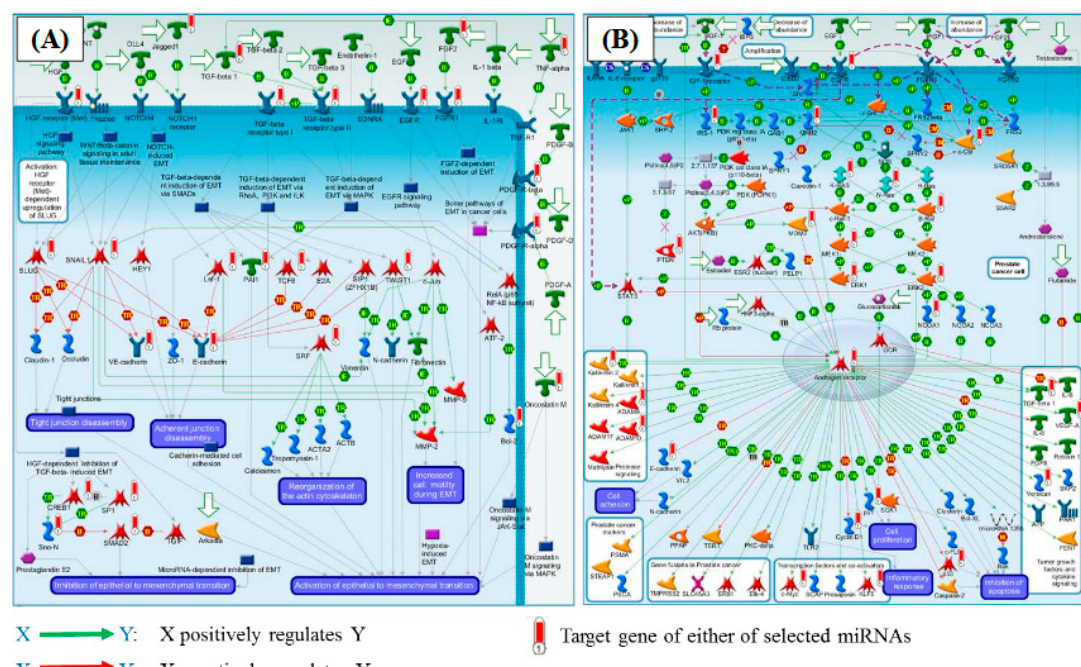
Figure 4. Representative pathways enriched with possible target genes of eight miRNAs whose plasma levels showed positive and negative correlations with CHA 2 DS 2 -VASc score and CA, respectively. ( A ) Pathway maps for “Development_Regulation of epithelial-to-mesenchymal transition (EMT)” and ( B ) “Pathway maps for “Androgen receptor activation and downstream signaling in Prostate cancer”, the 1st and 2nd most enriched pathways, respectively, querying possible target genes of the miRNA whose plasma levels showed positive correlations with CHA 2 DS 2 -VASc score (Table 3). Red bar represents possible target genes of miRNAs whose plasma levels were positively and negatively correlated with CHA 2 DS 2 -VASc score and CA, respectively. Green and red arrows mean positive and negative regulation of the target genes,